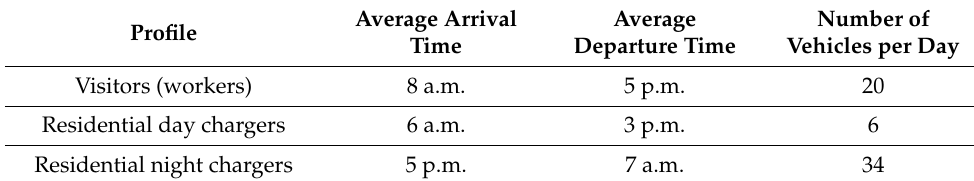
Table 2. Future charging profiles.